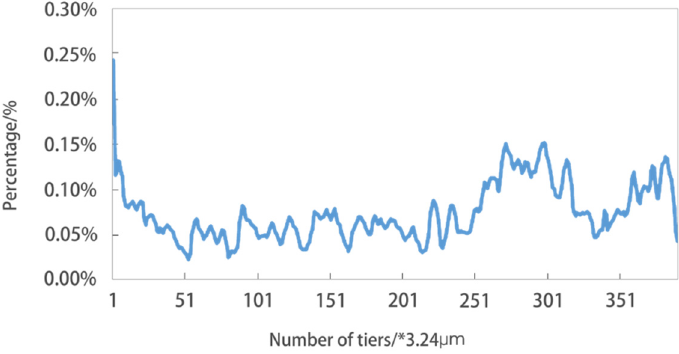
Figure 18. Diagram of volume proportion change in the metal minerals along the direction of sample thickness.